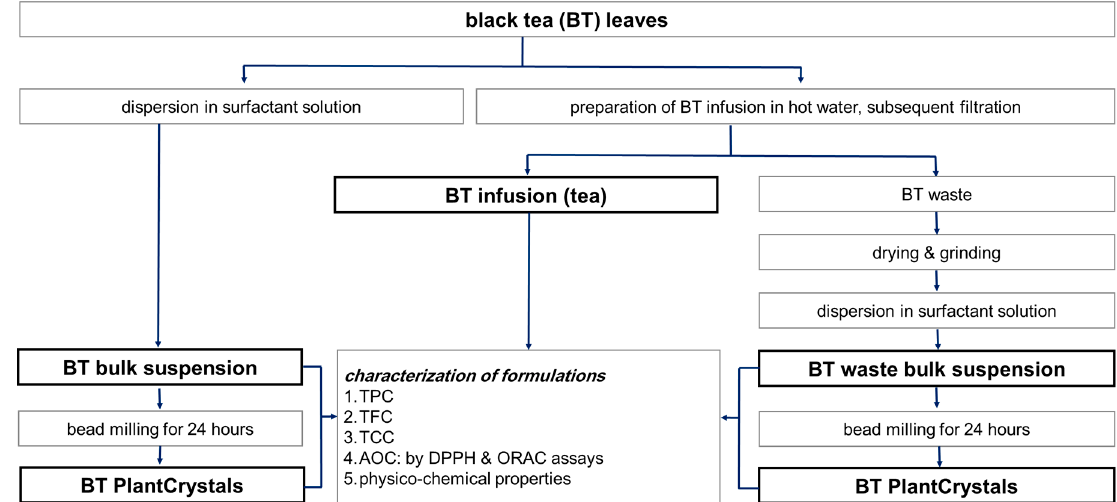
Figure 2. Scheme of the study showing the production and characterization of PlantCrystals from black tea (BT) and its waste. TPC: total polyphenol content, TFC: total flavonoid content, TCC: total carotenoid content and AOC: antioxidant capacity by using DPPH (1,1-diphenyl-2-picrylhydrazyl) and ORAC (oxygen radical absorbance capacity) assays. Physico-chemical properties include: particle size, morphology and zeta-potential.